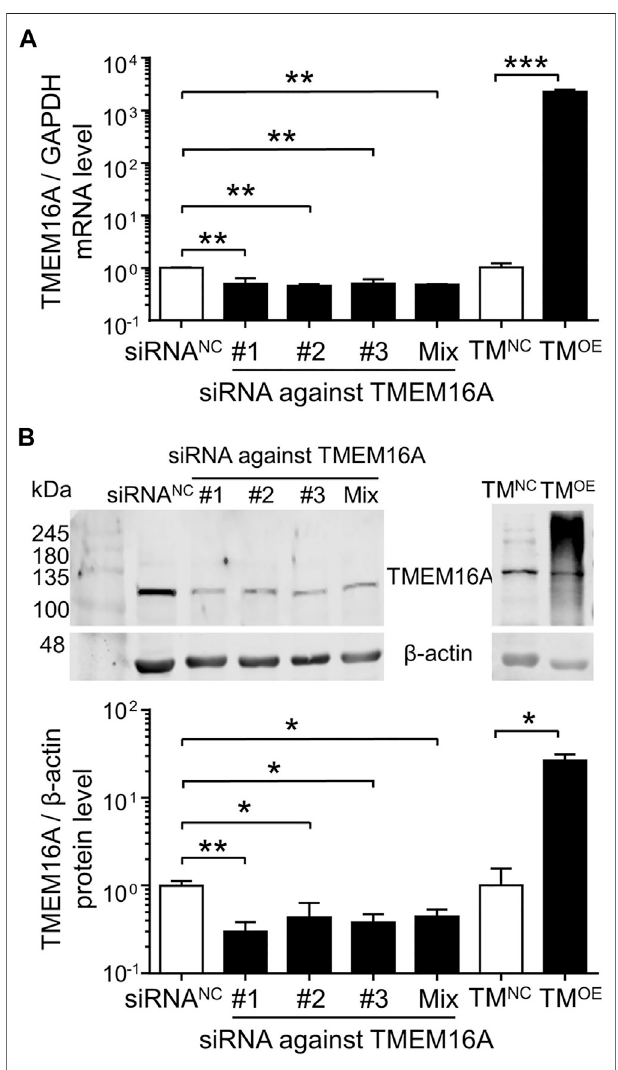
FIGURE 5 | Molecular expression levels of TMEM16A in HUVECs. (A) TMEM16A mRNA expression level in HUVECs (n = 3 – 4). (B) Western blot results of TMEM16A protein expression level in HUVECs ( n = 3 – 5). * p < 0.05, ** p < 0.01 and *** p < 0.001, one-way ANOVA and unpaired t -test.